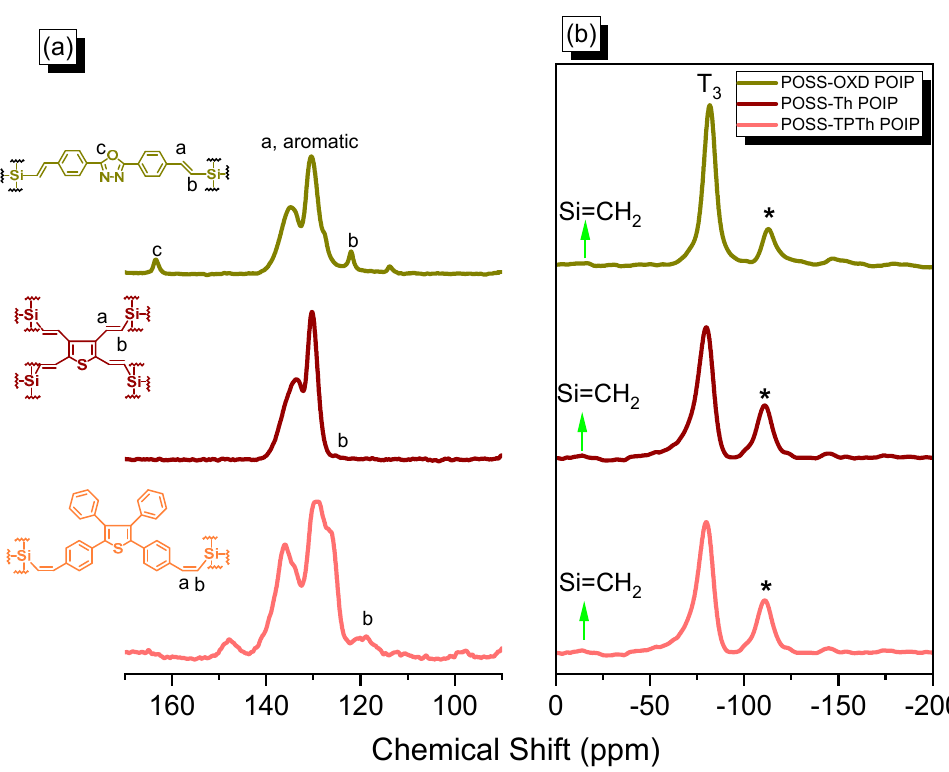
Figure 2. Solid state ( a ) 13 C and ( b ) 29 Si NMR spectra of the POSS-OXD, POSS-Th, and POSS-TPTh POIPs. * is the side band of solid state nuclear magnetic resonance spectroscopy (NMR).